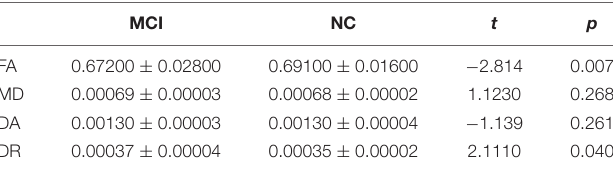
TABLE 4 | Whole-brain DTI